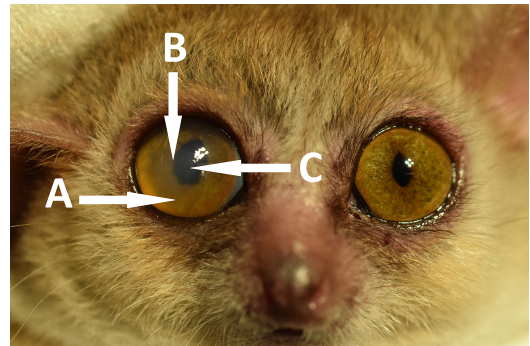
Figure 7. Three-year old mouse lemur with a unilateral complete anterior lens luxation on the right side. Because of the complete transparency of the lens, the luxation is only indicated by an in- complete miosis as well as the blurred iris (A) and distorted iris margin (B). The right cornea shows additional edema